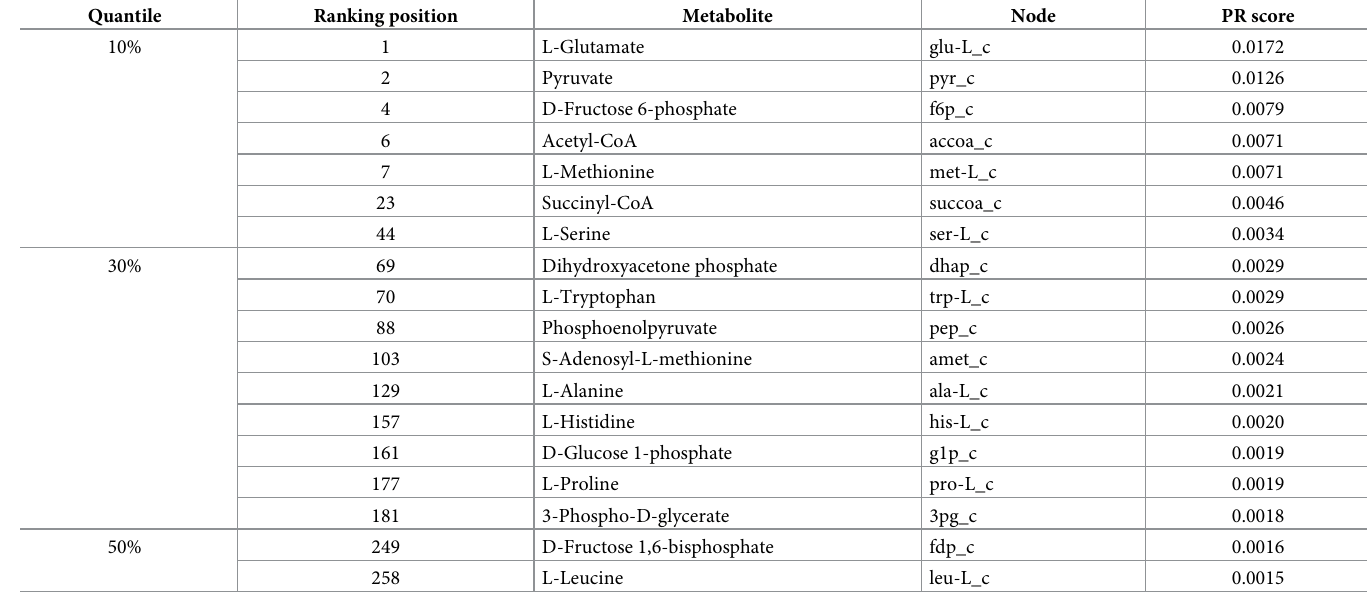
Table 5. Quantified metabolites in the top 50% of PageRank (PR) based analysis. The last position in the ranking (#622) was L-Tyrosine (PR score = 0.0004), which had been quantified. The full list can be found in (S4 Dataset).